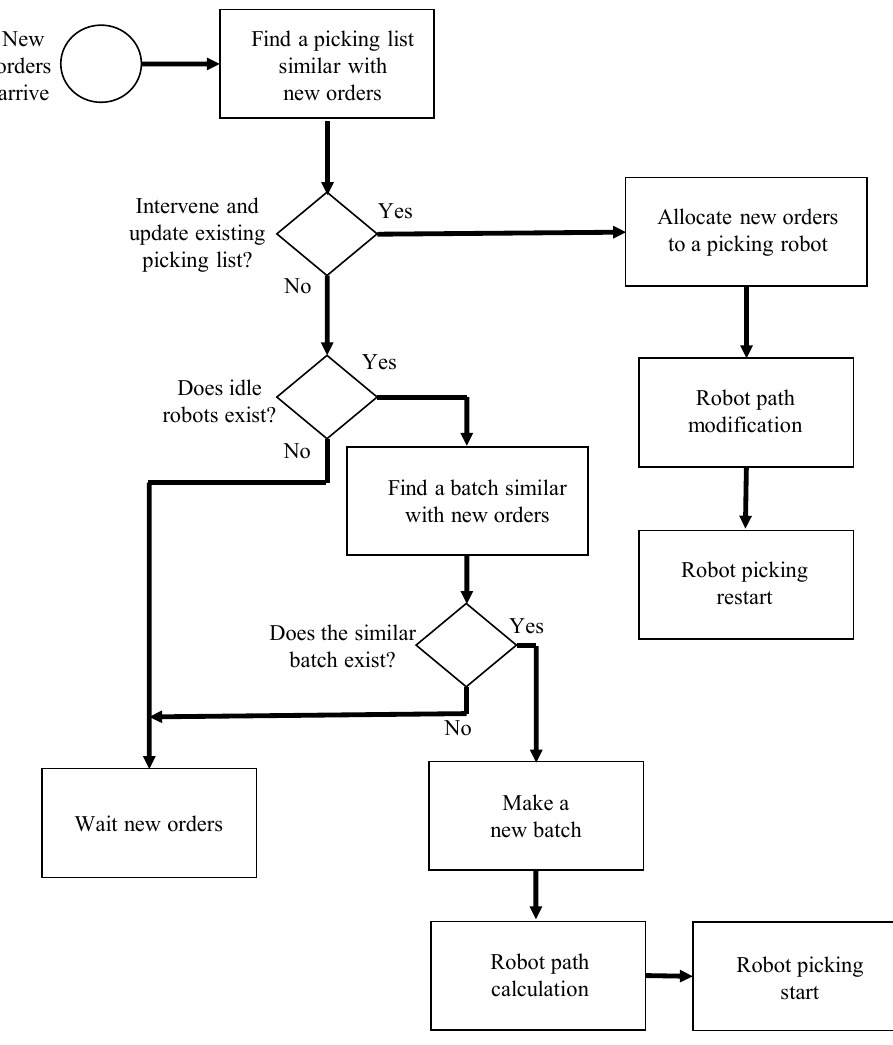
Figure 2. Proposed method flowchart based on similarities between new order and the pickup list. The proposed strategy either assigns a new order to the UAV or combines a new order with not allocated orders to make a new